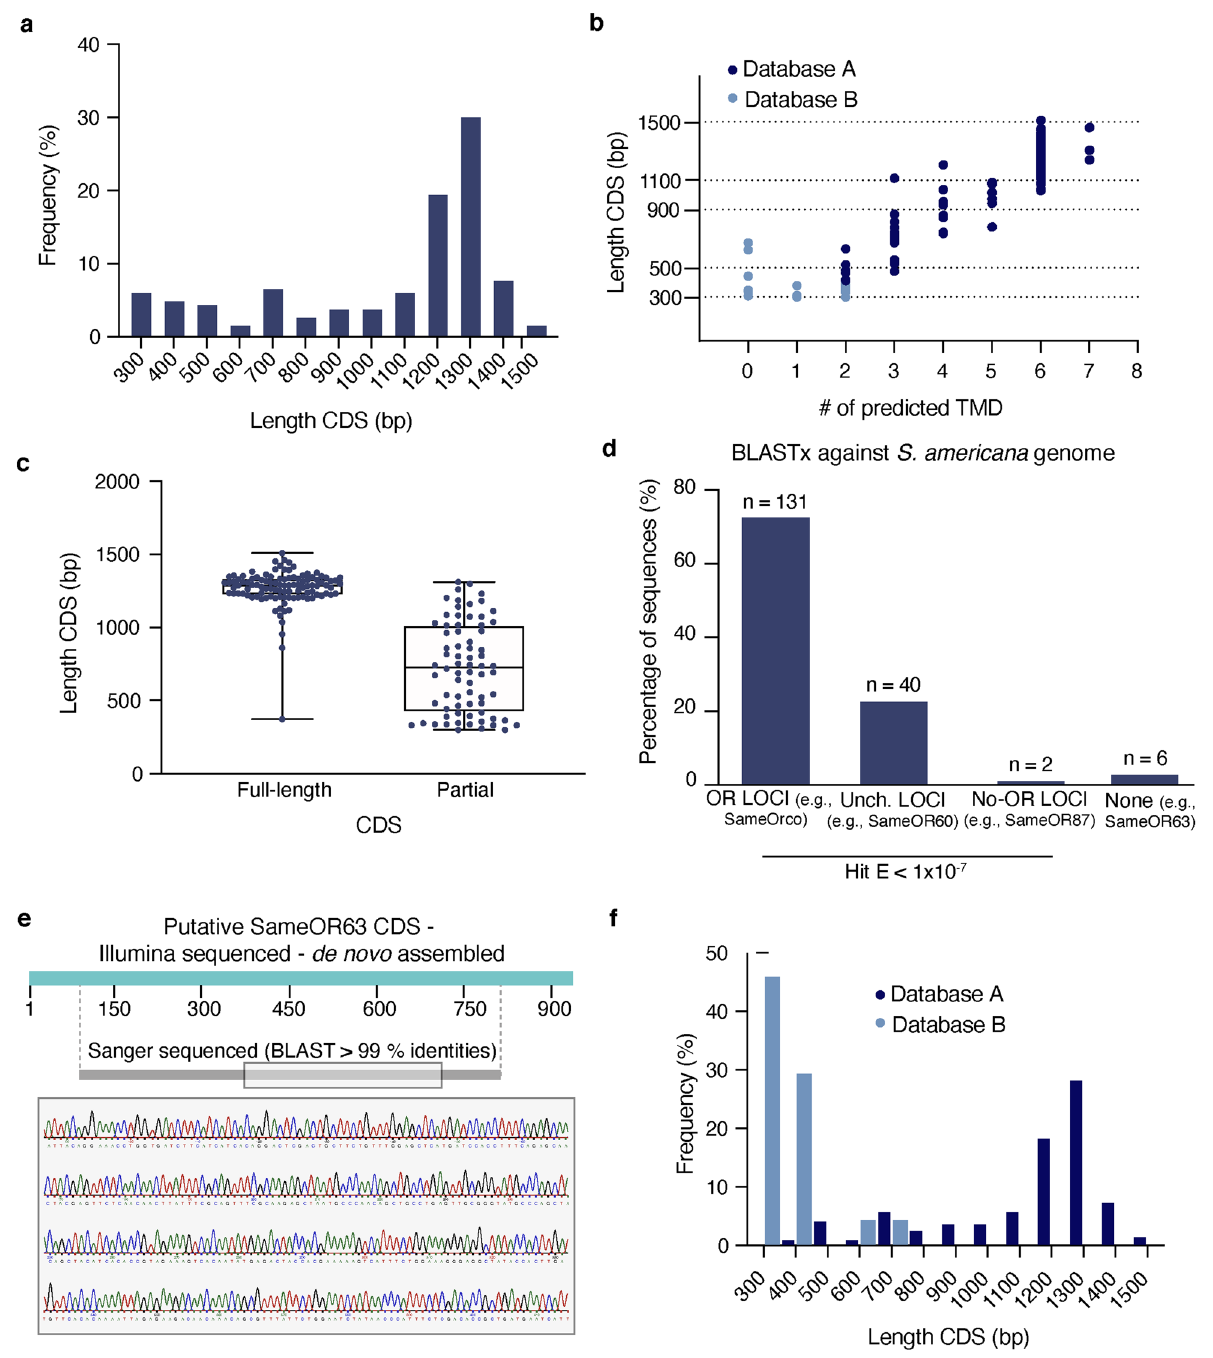
Figure 1. Statistical characterization of SameORs identified in the unified transcriptome assembly. ( a ) Frequency distribution of CDS length (bp). ( b ) Relation between CDS length and number of TMDs predicted from the deduced amino acid sequences of the 179 putative ORs. Putative OR sequences were divided into database A (dark blue) and database B (light blue) for further analysis. ( c ) Length of full and partial CDSs. ( d ) Blastx results of putative SameOR CDSs against a recently posted S. americana genome assembly. Shown are the percentage of sequences with a significant match (E < 1E −7 ) to either a predicted OR, an uncharacterized (Unch.) or a none-OR loci, and those that did not match any genomic region (None). ( e ) Schematic highlighting of SameOR63 CDS region amplified by RT-PCR and sequenced using Sanger. The Sanger chromatogram at the bottom is an example of the sequencing results. ( f ) Frequency distributions of CDS length in Database A (dark blue) and Database B (light